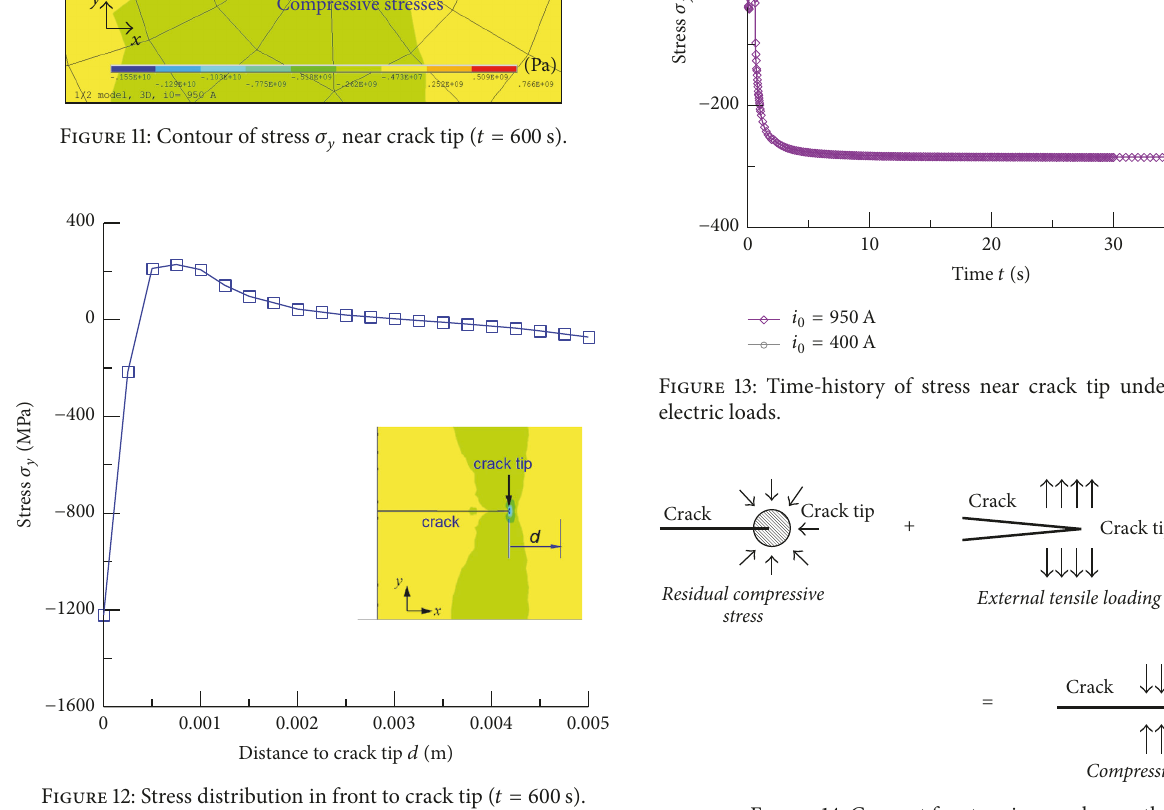
Figure 14: Concept for stopping crack